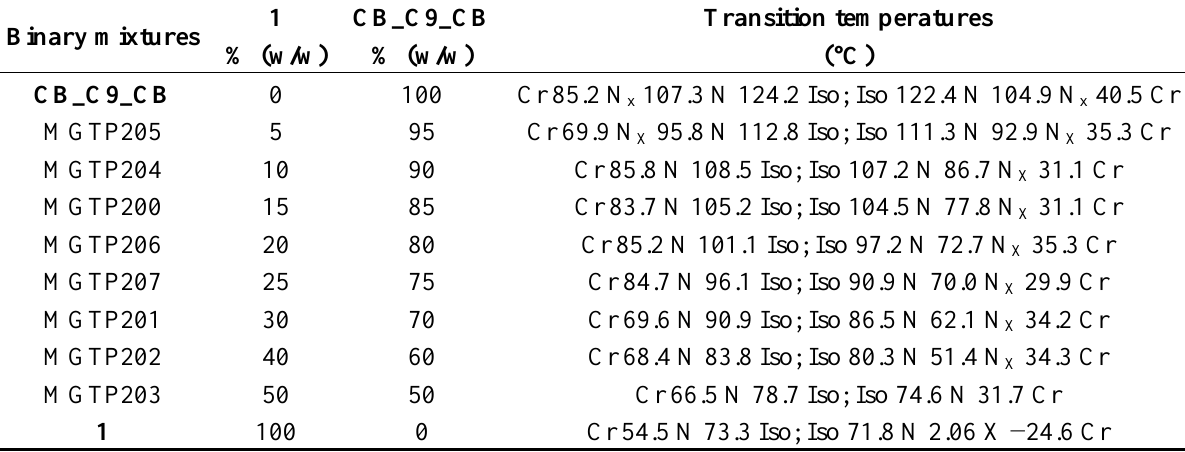
Table 1. Transition temperatures of the binary mixtures (w/w) of 1 with dimer CB_C9_CB , taken from the first DSC heating and cooling scans (10 K∙min −1 ). Cr = Crystallie; N = Nematic; Nx = Nematic (x or tb); Iso = isotropic liquid.